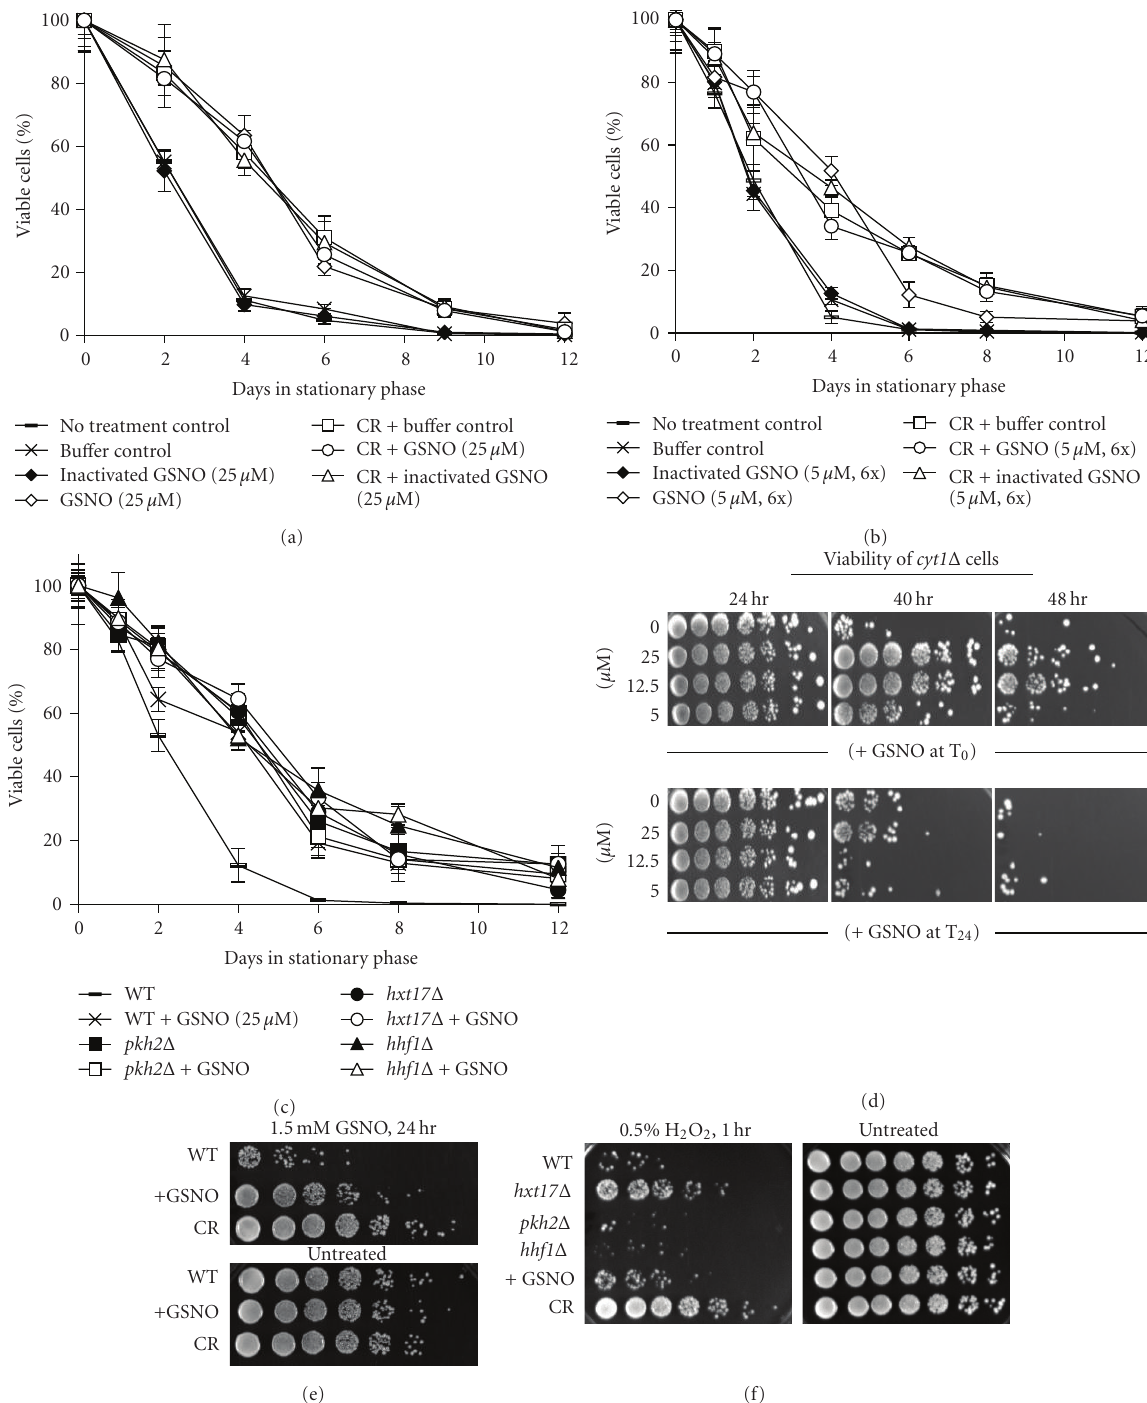
Figure 6: GSNO treatments extend chronological lifespan (CLS). (a and b) Treating cells with low doses of GSNO extends CLS. (a) Cells are treated with a single dose of GSNO at a final concentration of 25 μ M upon starting the CLS assay (at 0hr). (b) Cells are treated with GSNO at a final concentration of 5 μ M at six di ff erent time points (6x): 0, 3, 6, 9, 18, and 24 hr. (c) GSNO treatment does not further increase the long CLS of representative CR mimic mutants. (d) GSNO treatments partially rescue the short CLS of the cyt1 Δ mutant. Results show relative viability of cells taken from GSNO-treated CLS culture (in 5-fold serial dilutions). T 0 : treating cells with GSNO upon starting CLS; T 24 : treating cells with GSNO 24hr after starting CLS. (e) Cells pretreated with 25 μ M GSNO (+GSNO) show resistance towards GSNO- induced toxicity. (f) Cells pretreated with 25 μ M GSNO (+GSNO) show mild resistance towards hydrogen peroxide-induced toxicity. WT: BY4742 wild-type control; CR: 0.5% glucose. One representative set of three independent experiments, each conducted in quadruplicate (for a, b, and c), is shown. Error bars denote standard deviations. For (a) to (c), numbers on x -axes denote the number of days after entering stationary phase (nonmitotic